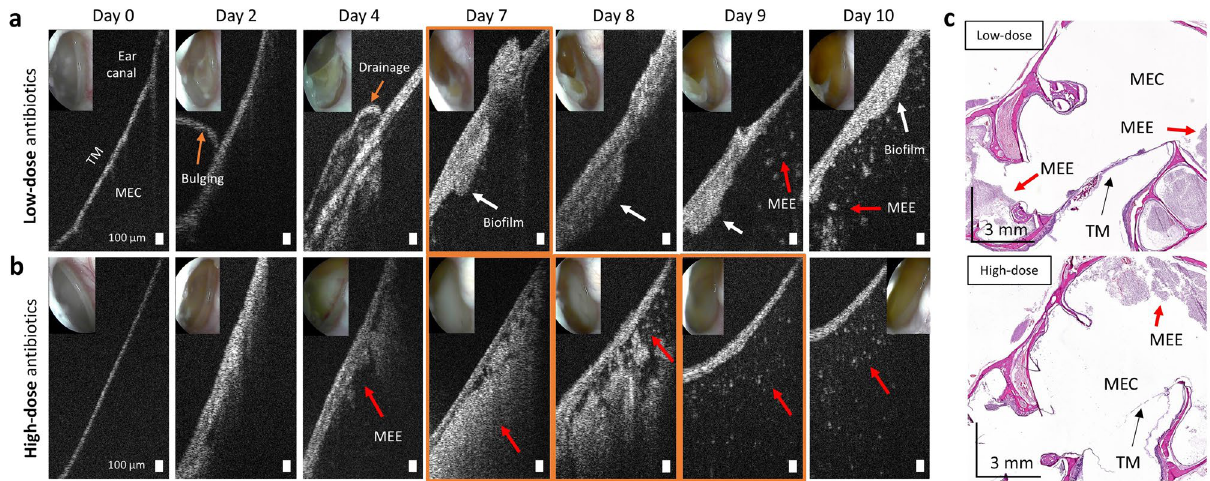
Figure 6. The presence of MEE and biofilm remained after antibiotic therapy. OCT and otoscopy (inset) images of two AOM-induced chinchillas from ( a ) low-dose and ( b ) high-dose antibiotic treatment groups. Both chinchillas showed the presence of the MEE (red arrows) through day 10, and a thick biofilm was visualized (white arrows). OCT image boundaries in orange note days given antibiotics. Scale bars represent 100 µm. ( c ) Histologic images of ( a ) and ( b ) on day 10, visualizing the MEEs in the middle ear cavities (MECs).